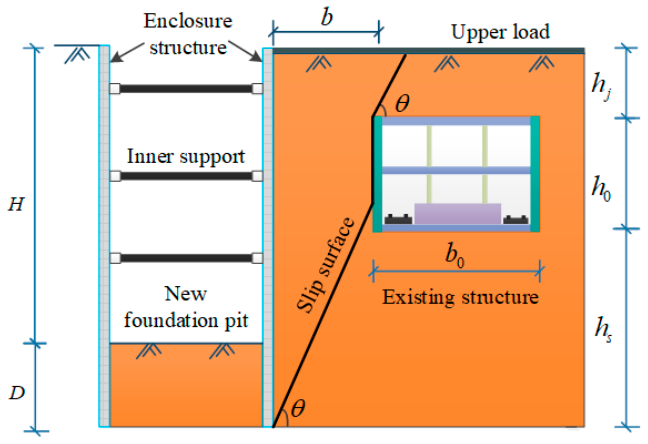
Figure 3. Soil failure